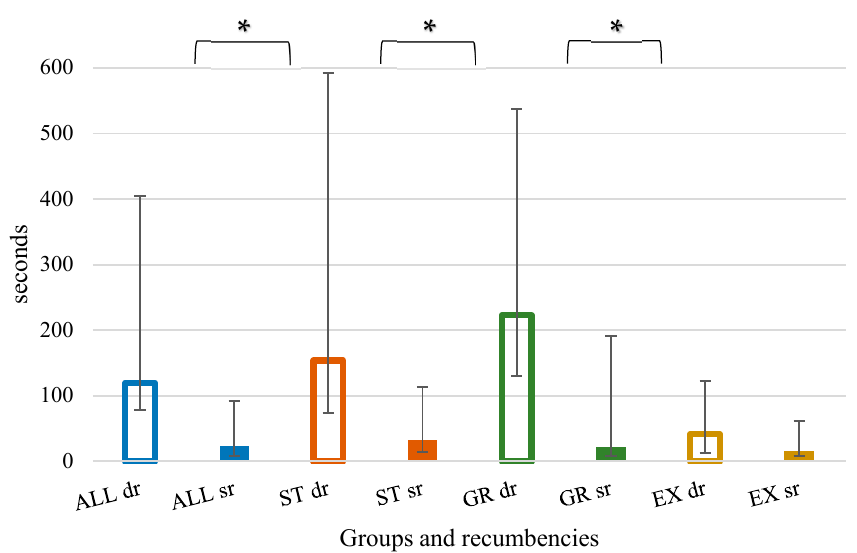
Figure 2. Time (seconds) needed to achieve a correct endotracheal intubation. Groups are identified by colours: blue—all; orange—undergraduates (ST); green—graduates (GR); yellow—experts (EX). Recumbencies are identified by bar fill: dorsal recumbency (dr)—no fill; sternal recumbency (sr)—full fill. * Statistically significant difference between recumbencies.